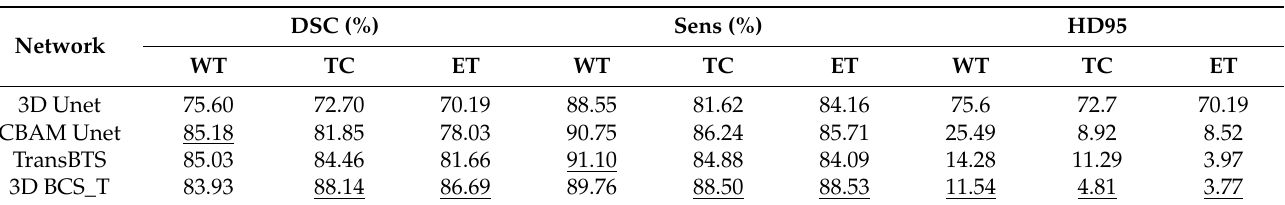
Figure 8. Comparison of the greyscale image segmentation results. ( a ) Pre-improvement segmenta- tion; ( b ) Post-improvement segmentation. Table 5. Comparison of the evaluation results of the different network models. The underlined data indicate that the network model has the best evaluation result compared with other models under the same evaluation index and